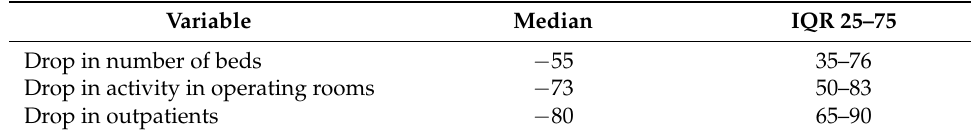
Table 4. Reduction of activities. Interquartile range (IQR), from 25th to 75th.